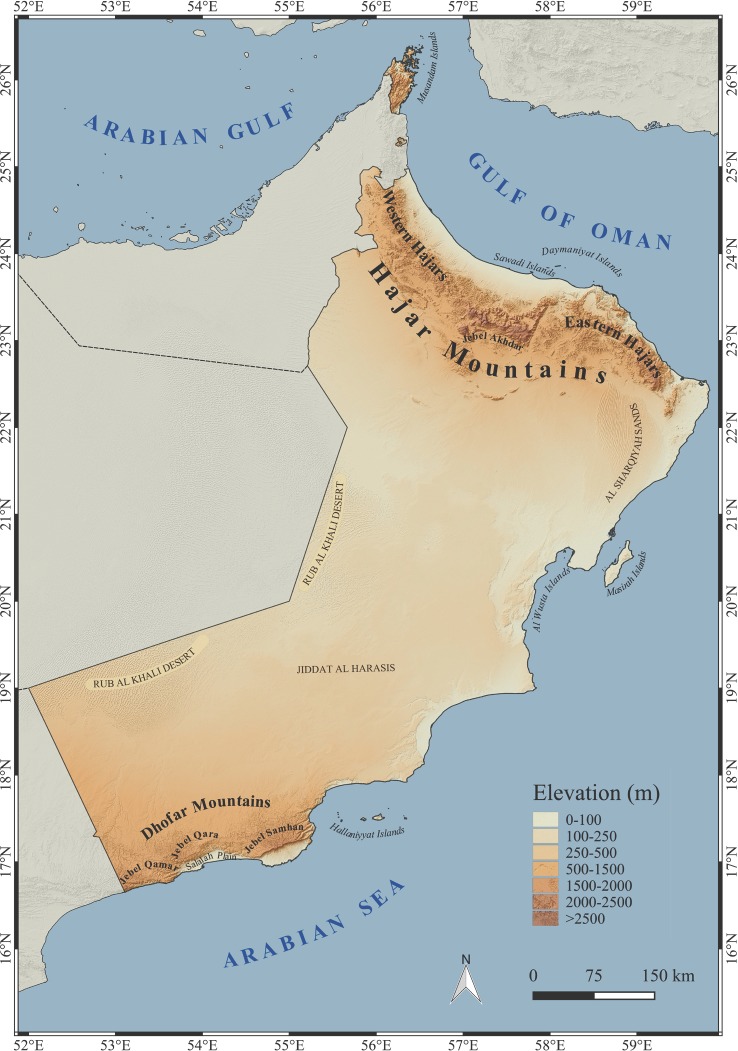
Physical map of Oman.Map of Oman showing topographical relief and names of the most relevant toponyms mentioned in this study.